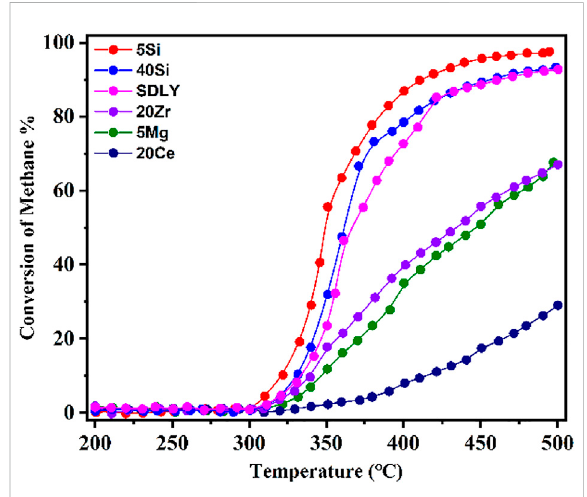
FIGURE 1 CH 4 combustion over a series of Pd (1 wt%) catalysts at temperatures from 200 to 500 ° C; Reaction conditions: 0.1% CH 4